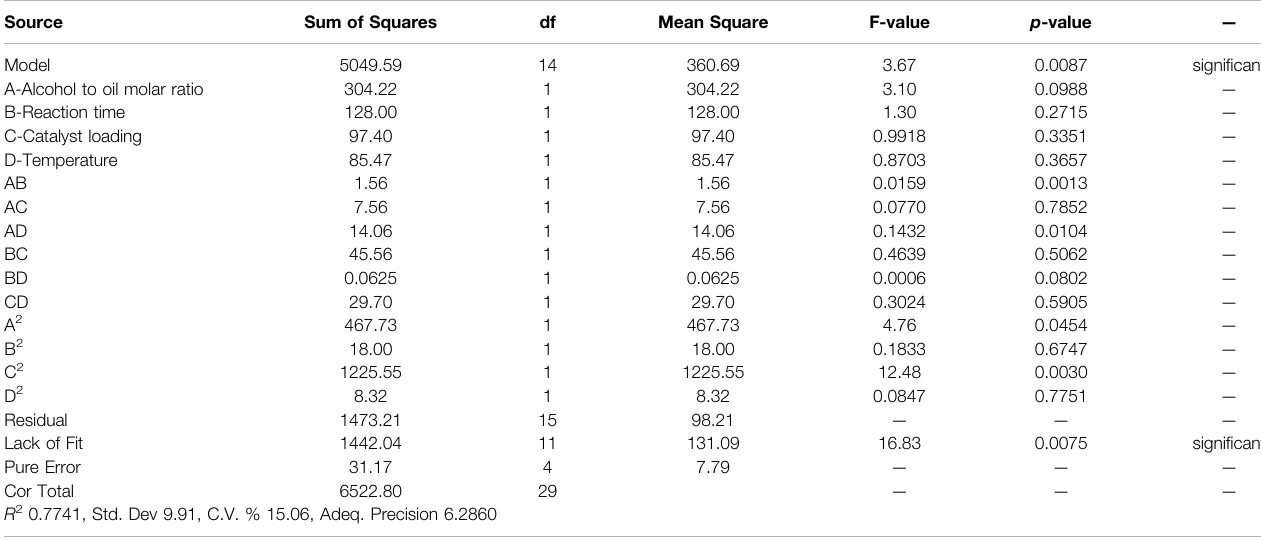
TABLE 2 | Analysis of variance (ANOVA) for